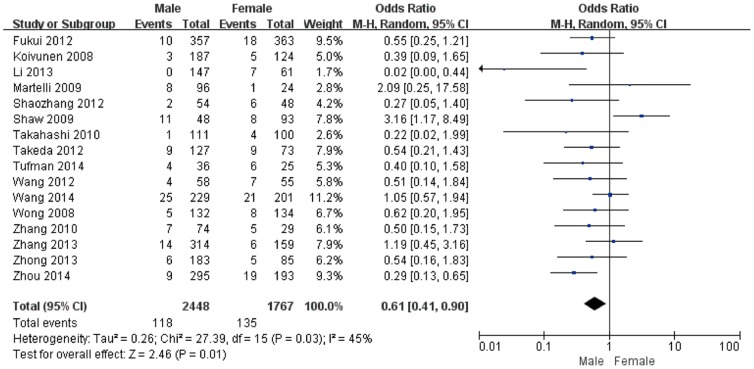
Forest plots of studies with an association between the EML4-ALK fusion gene and gender.